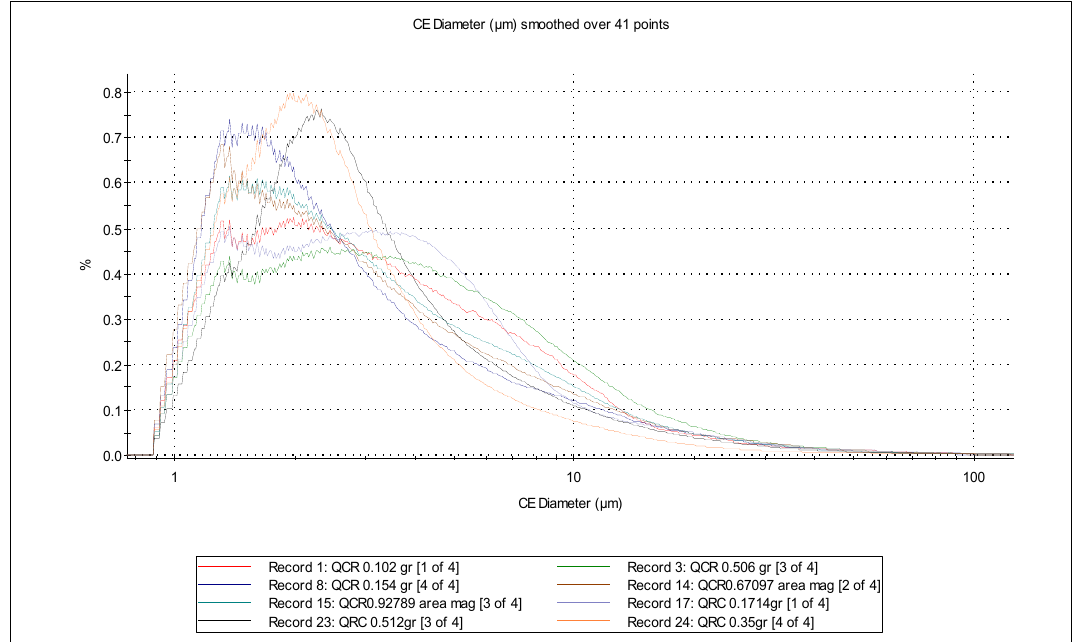
Figure 3. CE diameter distribution curves of quartz particles (the meaning of CE is “circle equivalent”; the curves are obtained from the smoothing by average of 41 readings; the results are expressed in x-y graphs and not in histograms, due to the high number of reading channels; and gr is the weight of sample, e.g., 0.102 gr as grams, 102 mg).